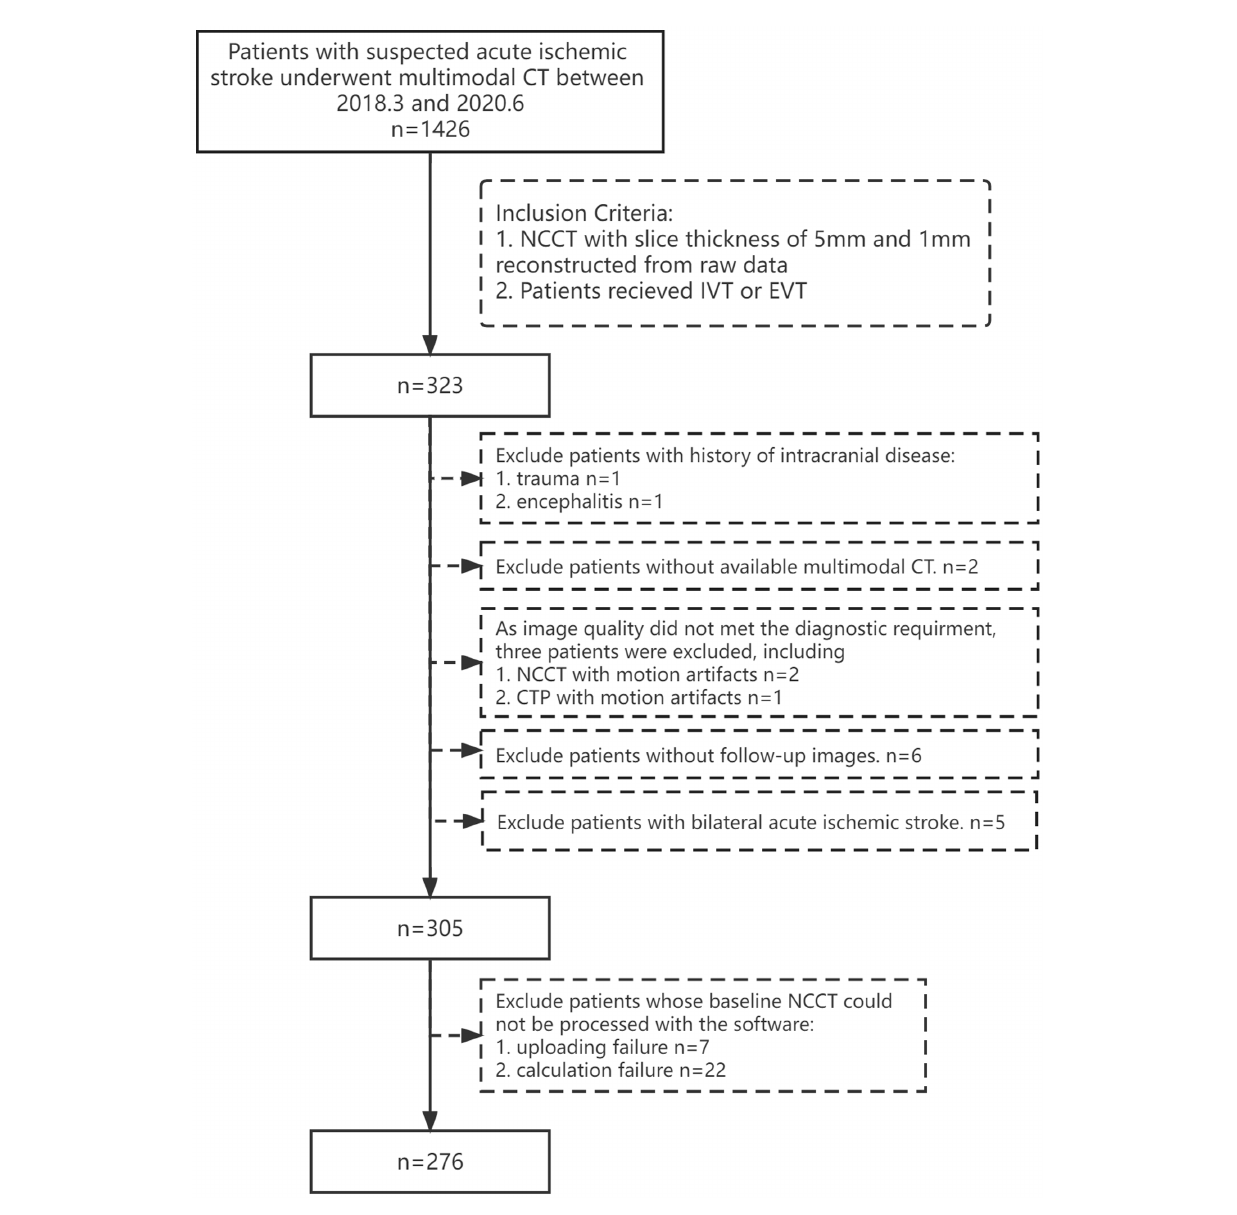
FIGURE 2 Flowchart showing the patient inclusion and exclusion criteria. IVT, intravenous thrombolysis; MT, mechanical